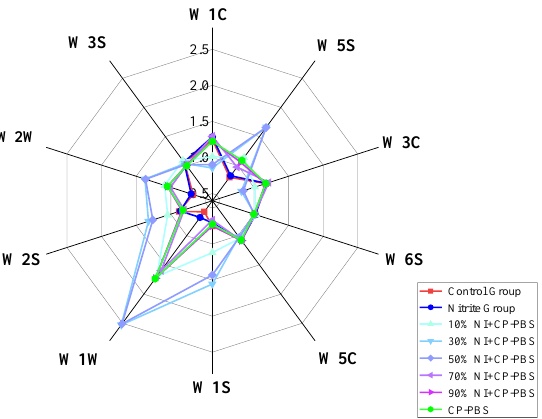
Figure 3. Radar of the volatile flavor substances of smoked sausage in different treatment groups.